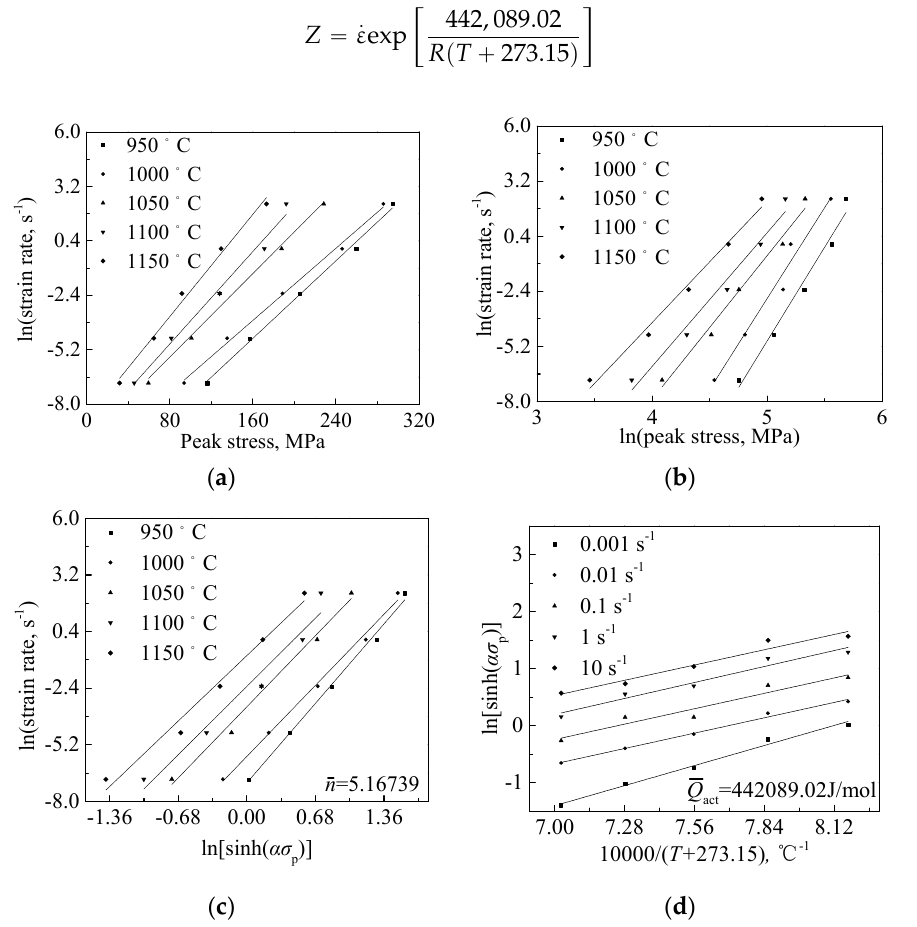
Figure 2. Relationships between: ( a ) peak stress and ln(strain rate); ( b ) ln(peak stress)and ln(strain rate); ( c ) ln[sinh( ασ p )] and ln(strain rate); ( d ) 10,000/( T + 273.15) and ln[sinh( ασ p )].